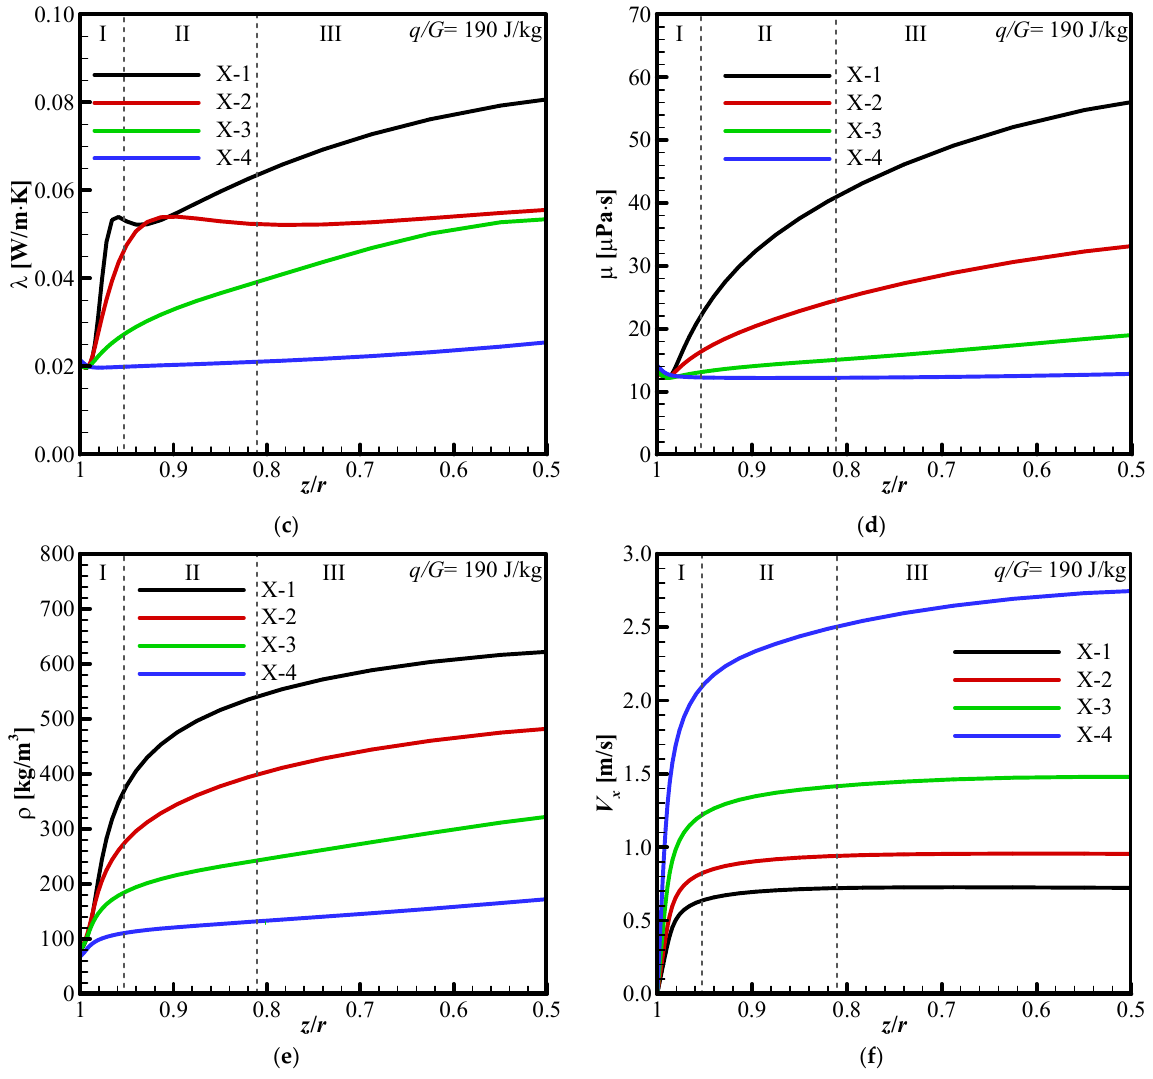
Figure 10. Radial variations at four different axial locations for the case with q / G = 190 J/kg at p = 3.8 MPa and G = 385 kg/m 2 · s: ( a ) temperature; ( b ) specific heat; ( c ) thermal conductivity; ( d ) viscosity; ( e ) density; and ( f ) axial velocity. z / r = 1 and 0 denote the wall and centerline of the tube,